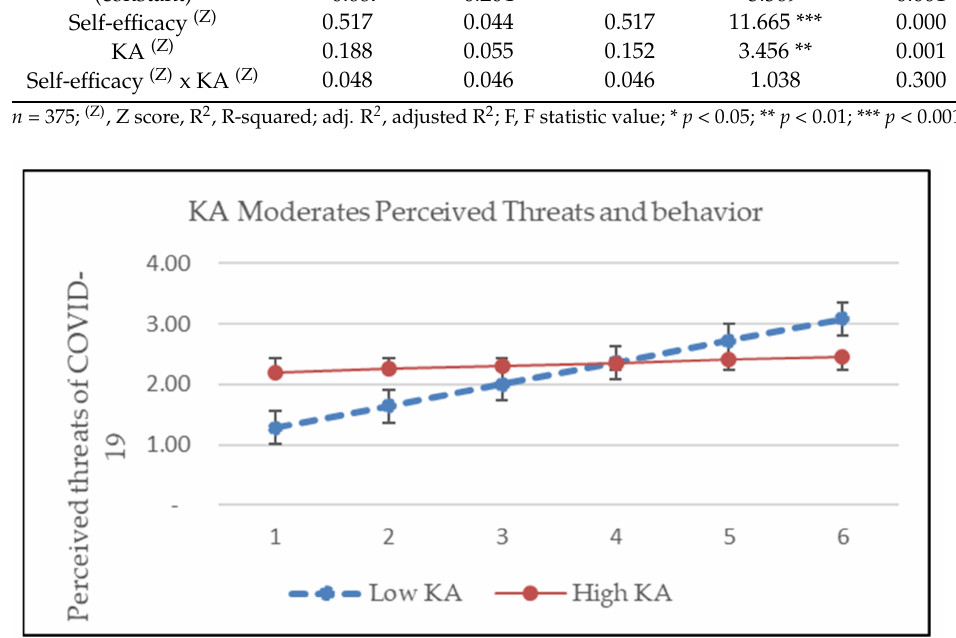
Figure 2. KA moderates perceived threats of